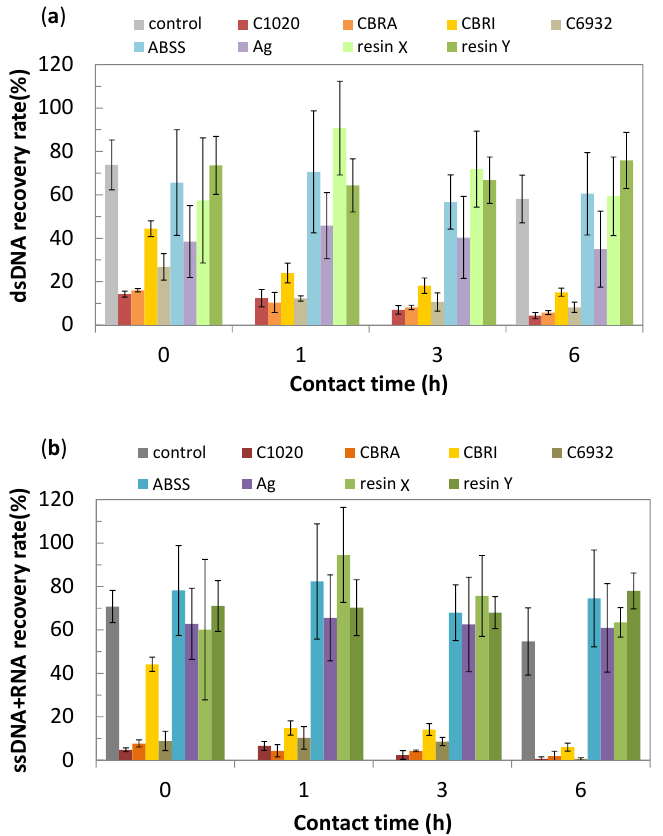
Figure 1. Recovery rates of ( a ) double-stranded deoxyribonucleic acids (dsDNAs) and ( b ) single-stranded (ss) DNA and ribonucleic acid (RNA) contacted on the material surface after a certain period of time (mean ± standard deviation).